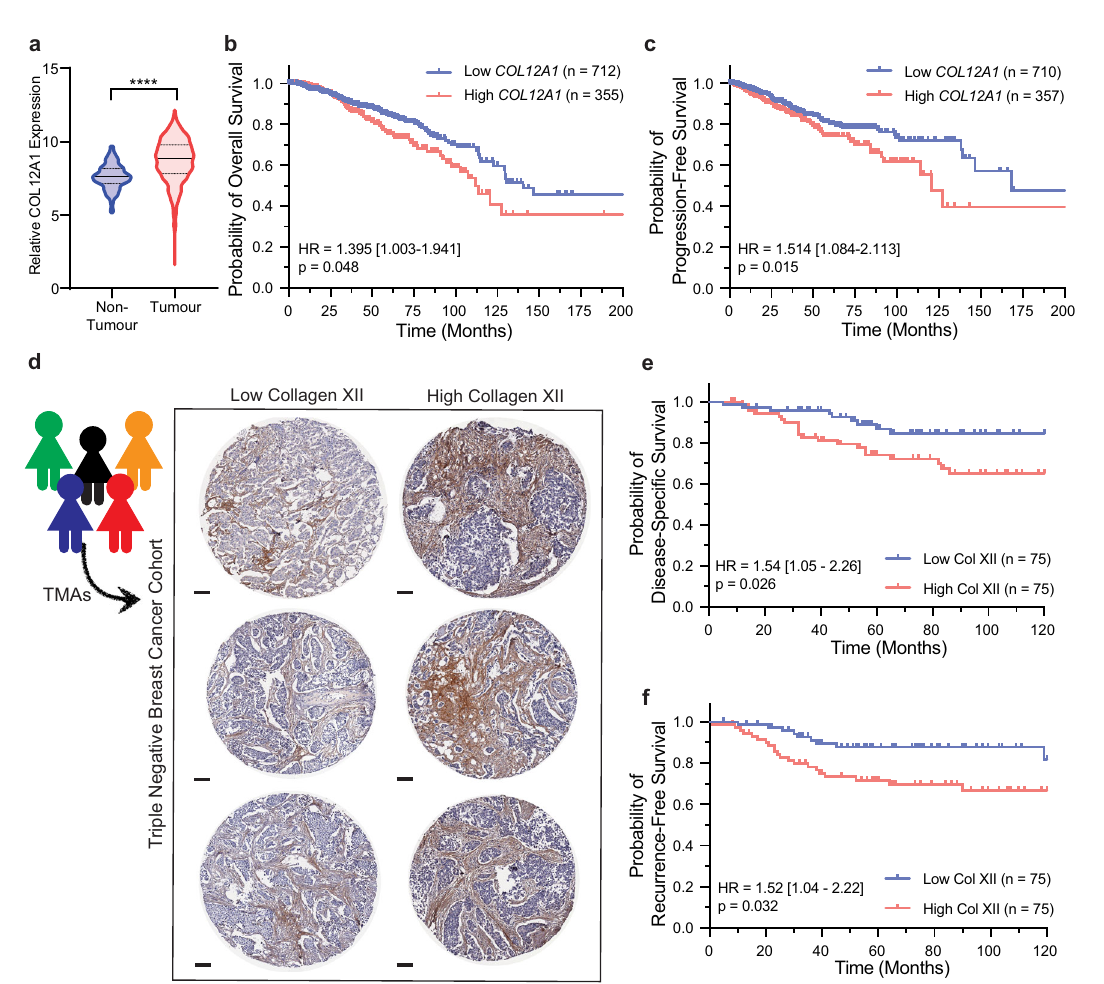
Fig. 4 | Collagen XII expression is associated with poor prognosis in human breast cancer. a COL12A1 expression in human non-tumour mammary tissue ( n =98) or primary tumour ( n =1080) from ‘ The Cancer Genome Atlas ’ (TCGA) breast adenocarcinoma cohort (BRCA) 60 (Median and interquartile range, p value determined by two-sided Mann-Whitney test (**** p <0.0001 Mann – Whitney U - test). b Kaplan – Meier overall survival and c progression-free survival analysis of collagen XII strati fi ed (tertiles) breast cancer patients from TCGA BRCA dataset ( n =1067). Univariate Cox Proportional Hazards Model hazard ratio (HR), HR 95%